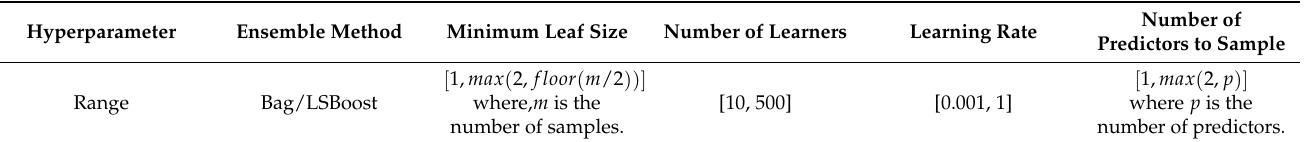
Table 3. The ranges of the ensemble model optimizable hyperparameters.